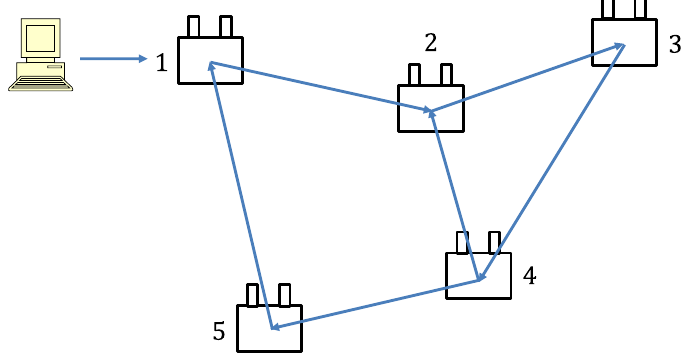
Figure 10. Communication topology of distributed BESS.